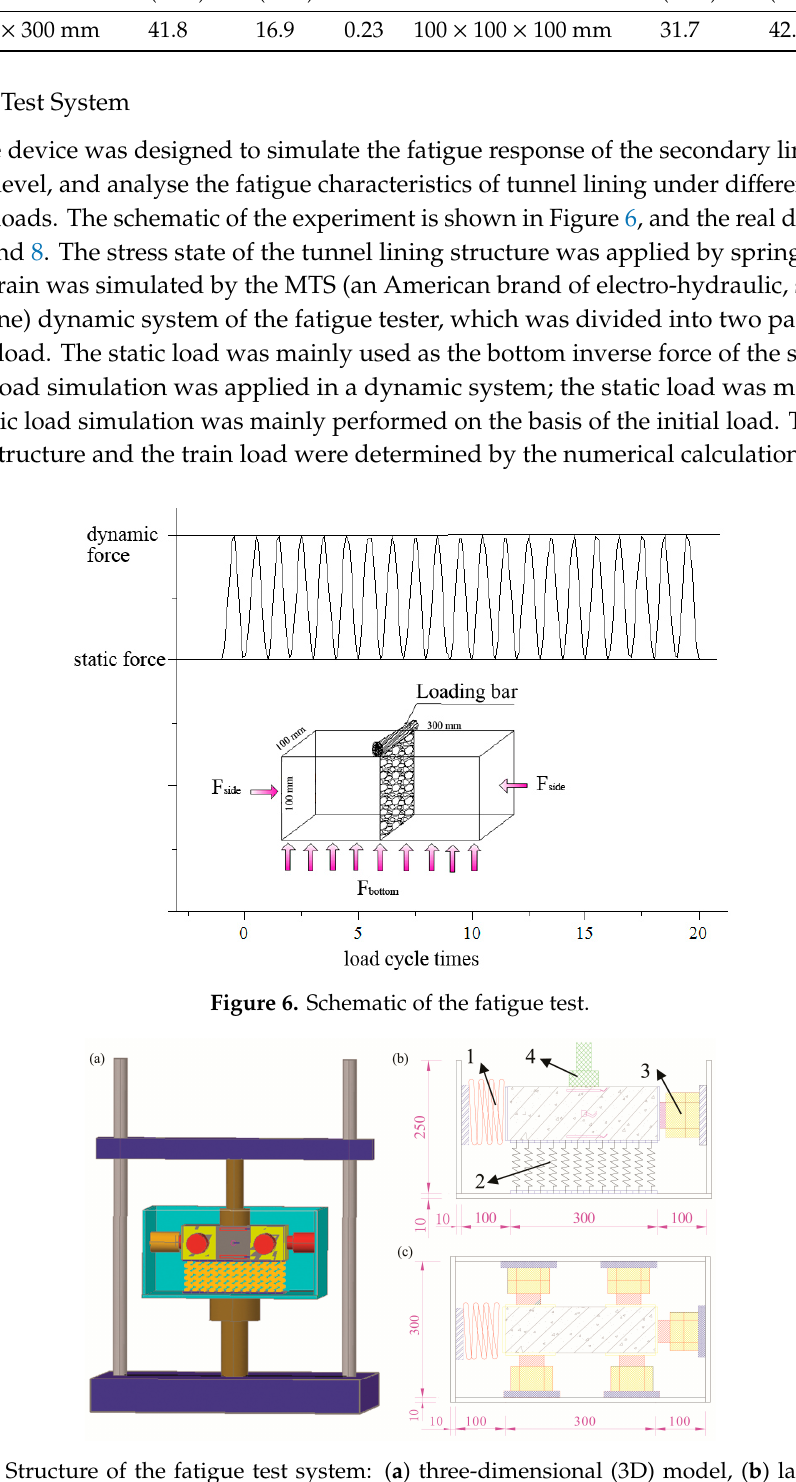
Figure 7. Structure of the fatigue test system: ( a ) three-dimensional (3D) model, ( b ) lateral view, and ( c ) top view; 1 and 2 refer to the lateral spring, 3 refers to the hydraulic jacks, and 4 refers to the MTS (American brand of electro-hydraulic, servo-material testing machine).